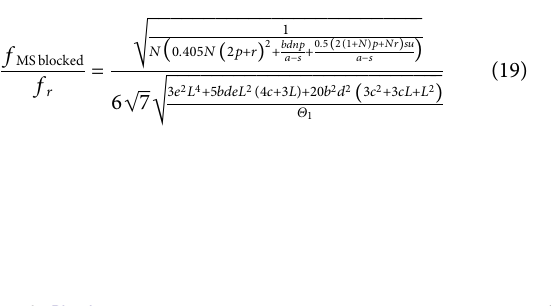
blocked internal oscillators normalized with the frequency of internal oscillators to get: